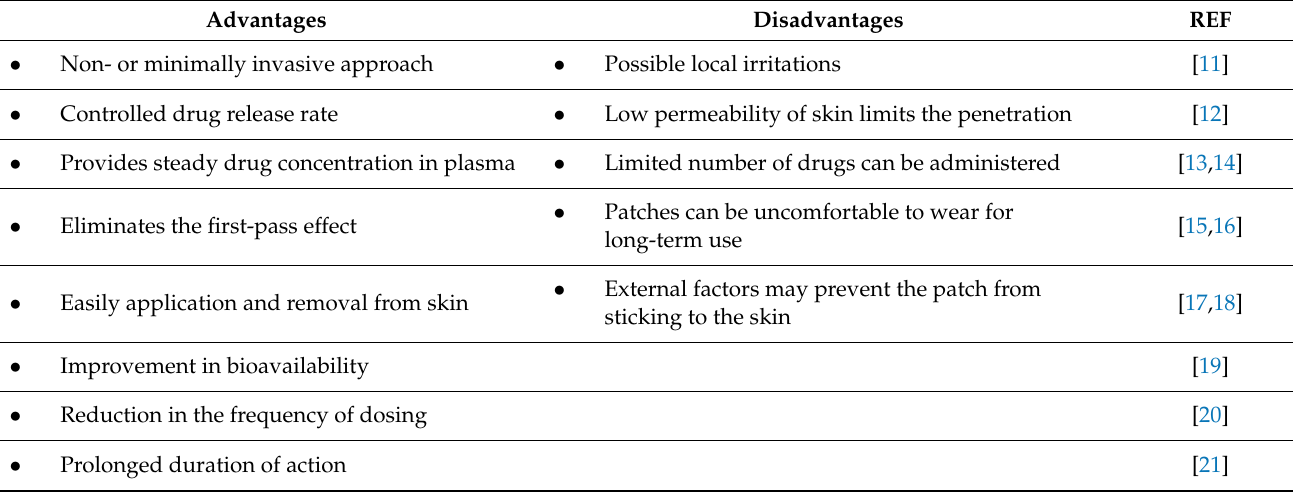
Figure 1. Main drug administration routes. Copyright permission for reuse from the refs. [9,10]. Table 1. Advantages and disadvantages of transdermal and dermal drug delivery systems.